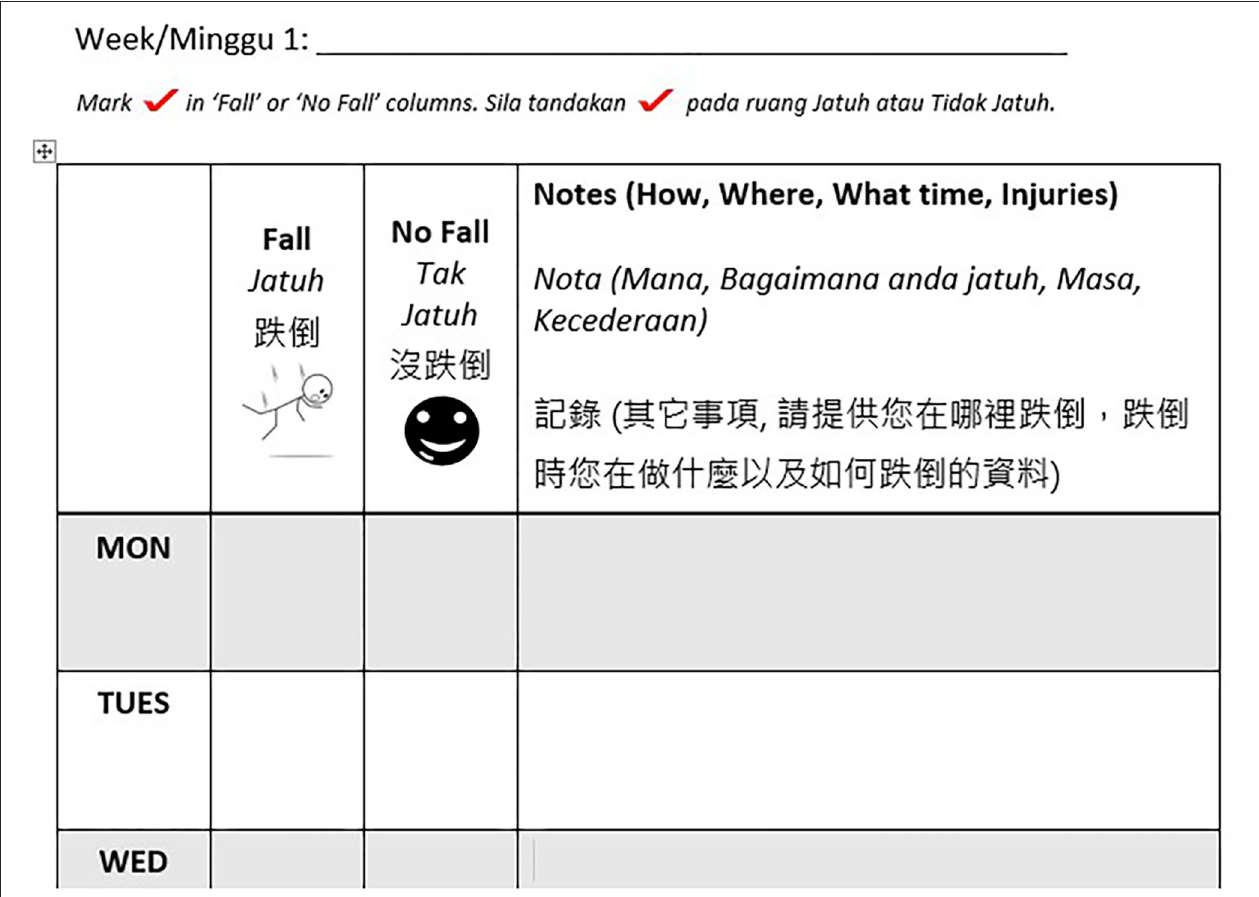
FIGURE 1 | A sample of the monthly diary with daily entries used in Malaysian Falls Assessment and Intervention Trial (MyFAIT). The top row contains the date completed by the researcher before posting the diaries out to the participants. The participant is required to complete the diary at the end of the day, by marking the column “fall” or “no fall,” next to the correct day of the week. The wider column is completed with free text if the older person is able to write or with the assistance of a friend or relative and is used to describe the mechanism, time, location, and injury associated with a